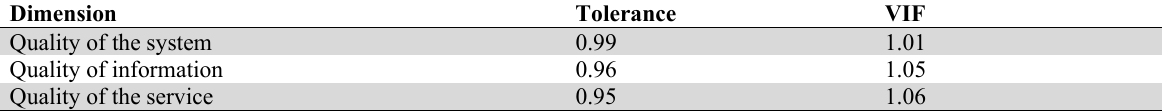
VIF test and the Tolerance allowed for the variables of the study Dimension Quality of the system